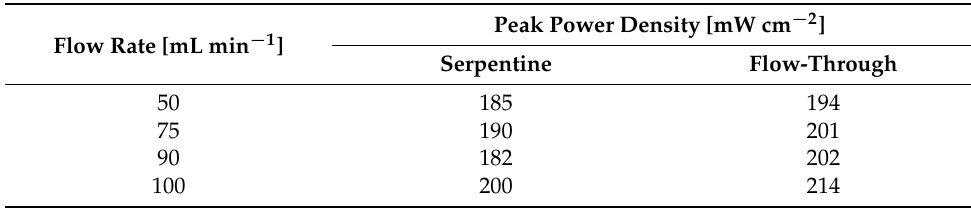
Table 1. Peak power density of ABRFB at SOC 50% for different flow fields and flow rate. Negolyte—ASM, Membrane—Nafion 211.